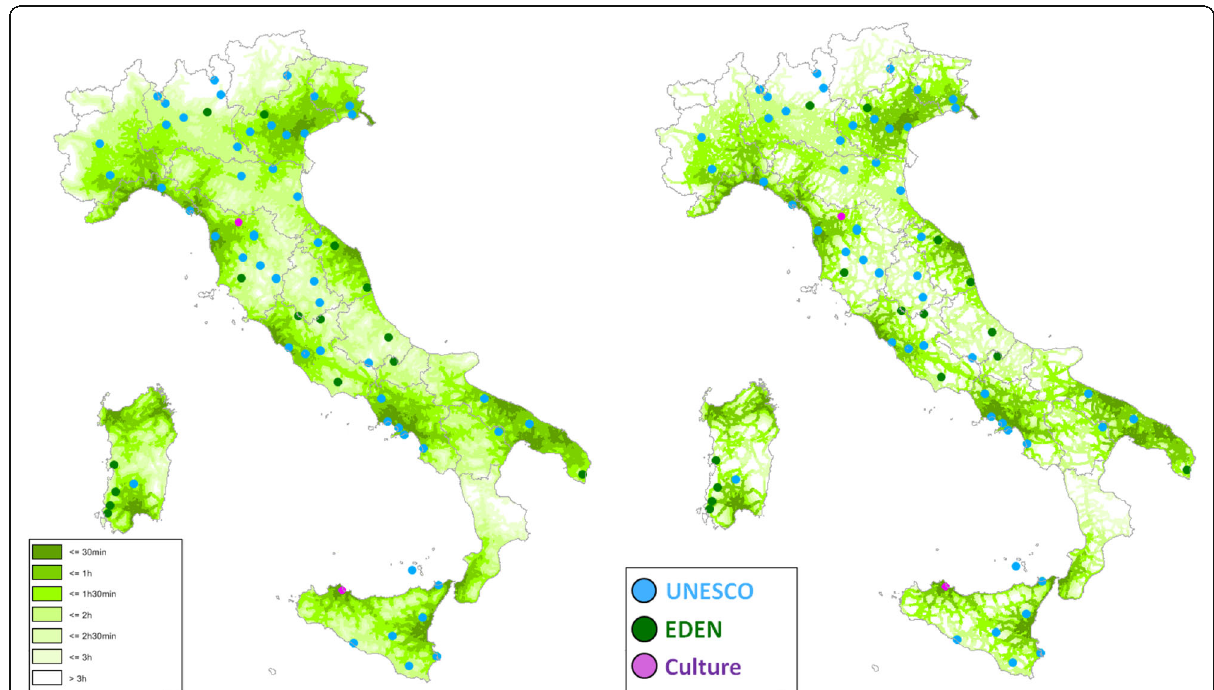
Fig. 4 travel times from the main ports to the selected tourist sites, on the road network (on the left) and using public transport (on the